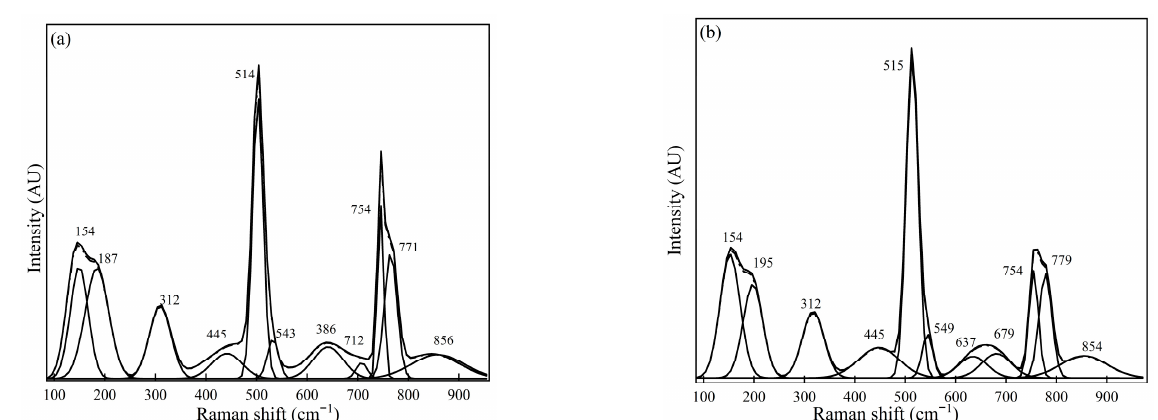
Figure 3. This Raman spectra for Sample #2 were measured using ( a ) spot measurements and ( b ) sample rotation (using the rotating stage).